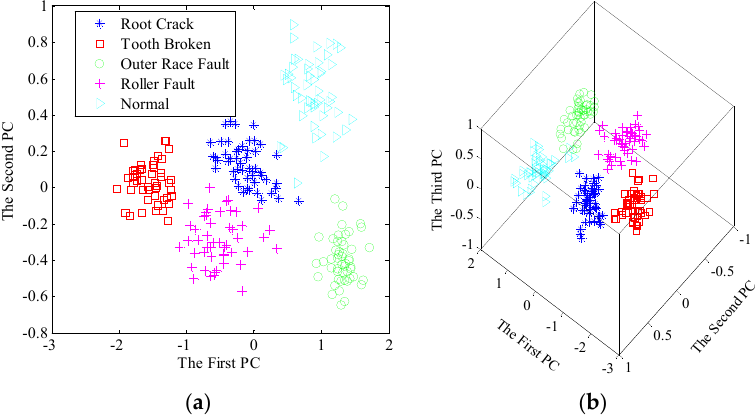
Table 3. Contribution rate of first few principal components in case 2.